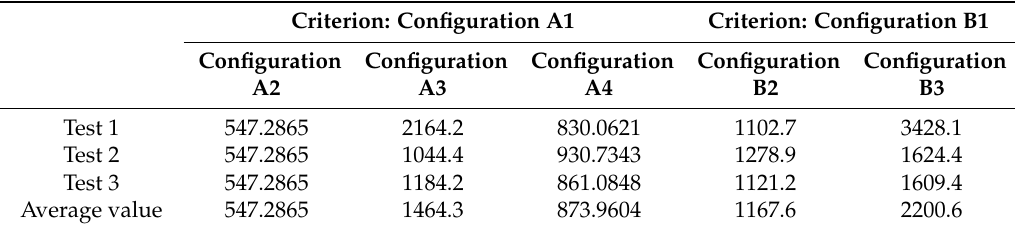
Table 12. The standard deviation of power battery power under different configurations (unit: W).